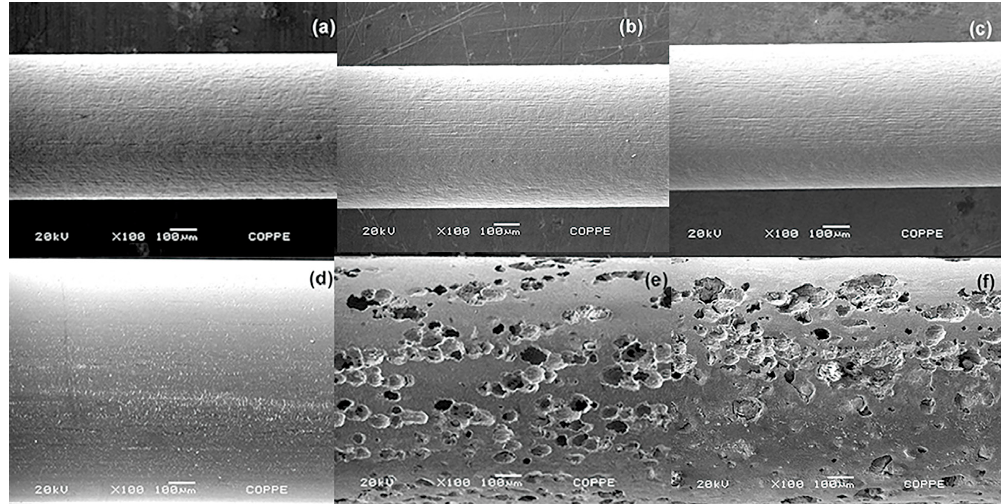
Figure 3. Polarization curves of NiTi and NiTiCu wires depending on sterilization condition in 0.9% NaCl solution.